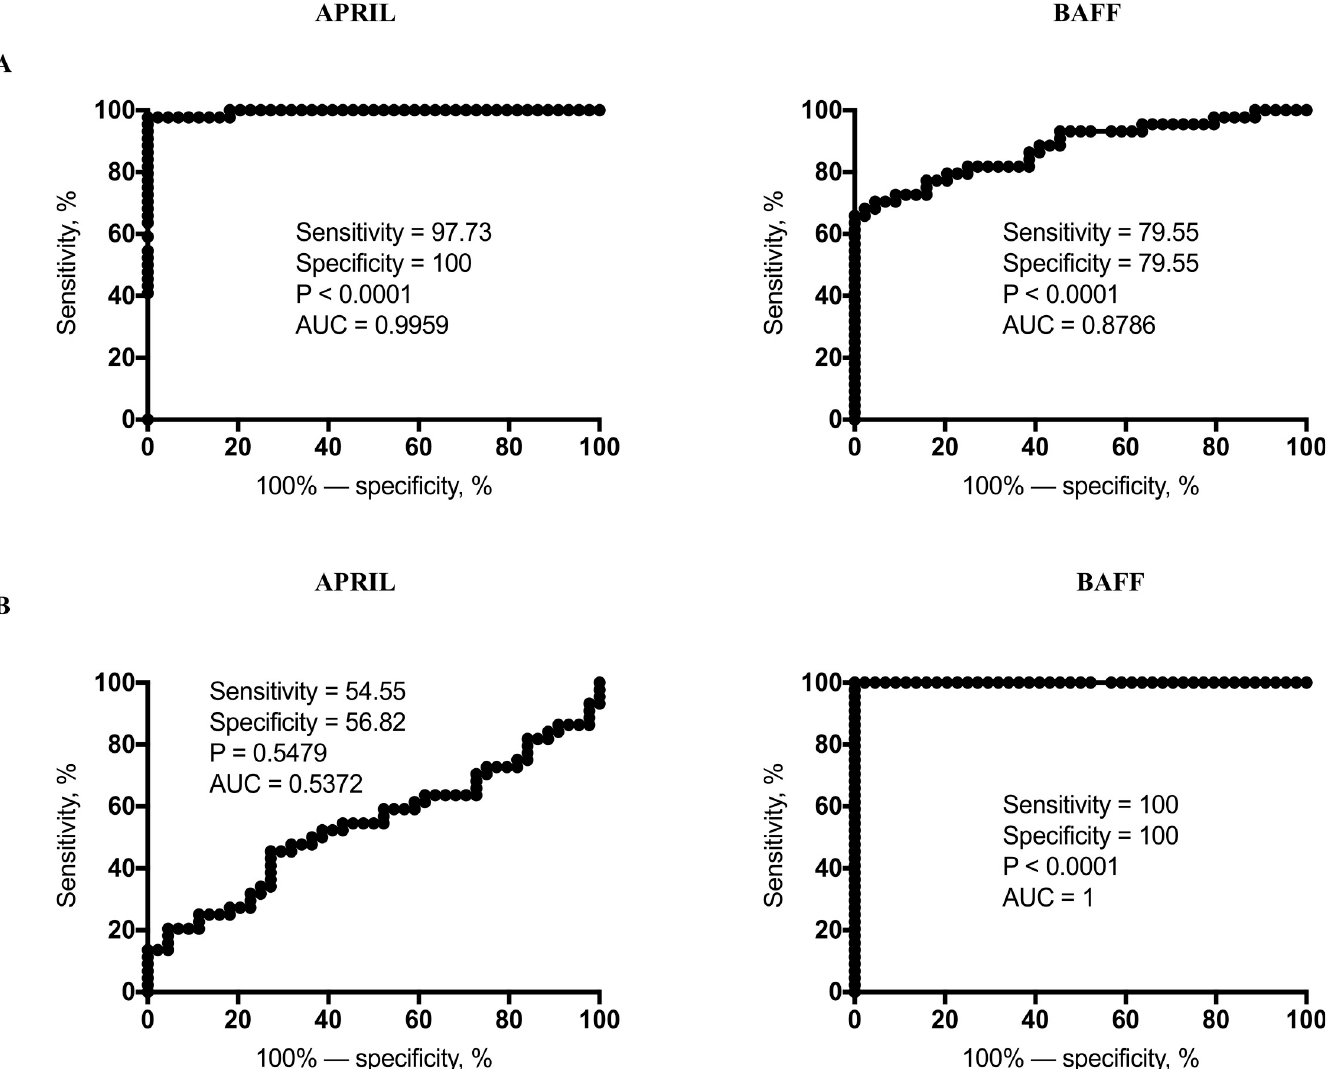
Fig 5. Receiver operating characteristic (ROC) analysis of APRIL and BAFF in PTB/TBL individuals. ROC analysis was performed to determine the sensitivity, specificity and area under the curve using the plasma levels of APRIL and BAFF cytokines between (A) PTB versus LTB and (B) TBL versus LTB to calculate the ability of these factors to distinguish PTB/TBL from LTB